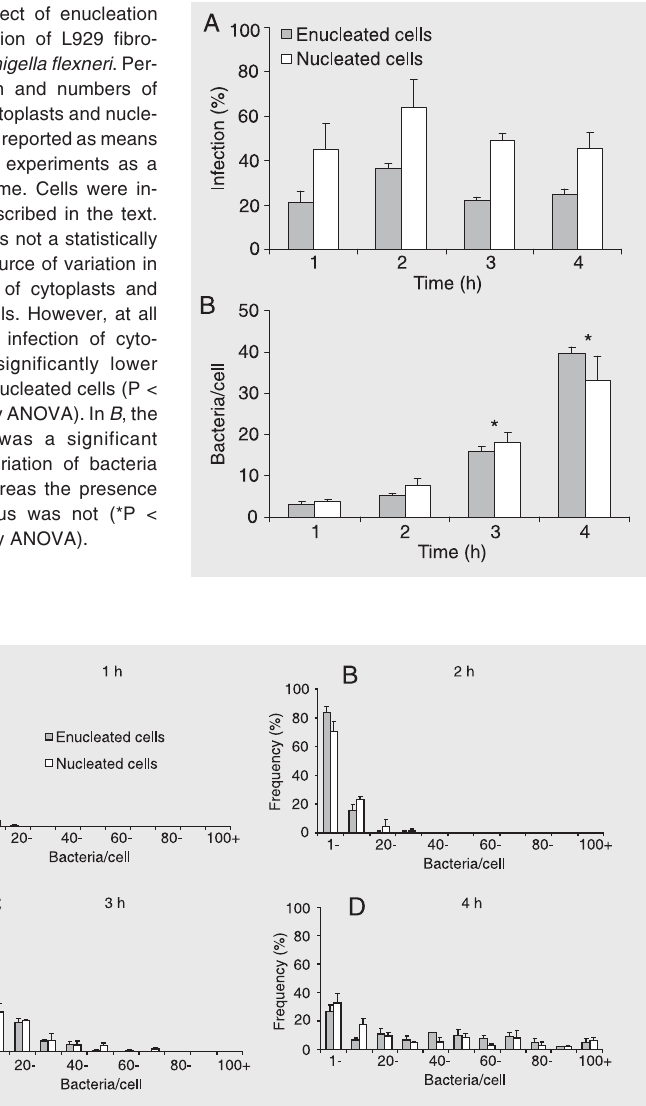
Figure 3. Effect of enucleation on the infection of L929 fibroblasts with Shigella flexneri in terms of frequency distributions of the number of bacteria per cell at intervals of 10 bacteria as percent of the total numbers of cells as a function of time. Cells were infected as described in the text, with cultures fixed at 1, 2, 3, and 4 h of infection, panels A-D respectively (data are reported as means ± SEM, from the same experiment as in Figure 2). Time was a statistically significant source of variation (P < 0.05, two-way ANOVA), whereas the presence of the nucleus was